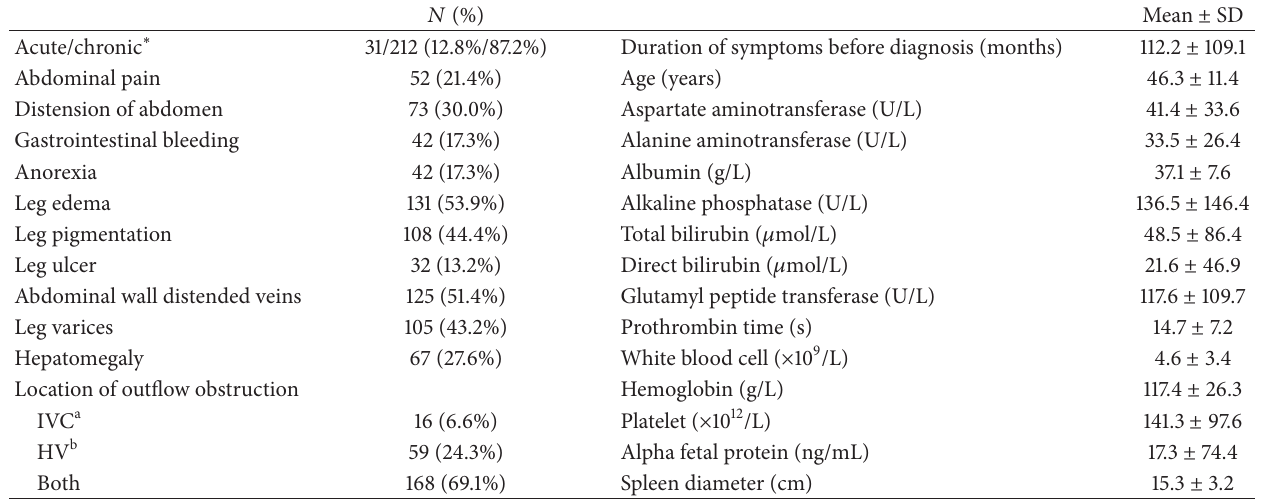
Table 1: Clinical data of 243 patients with Budd-Chiari syndrome at